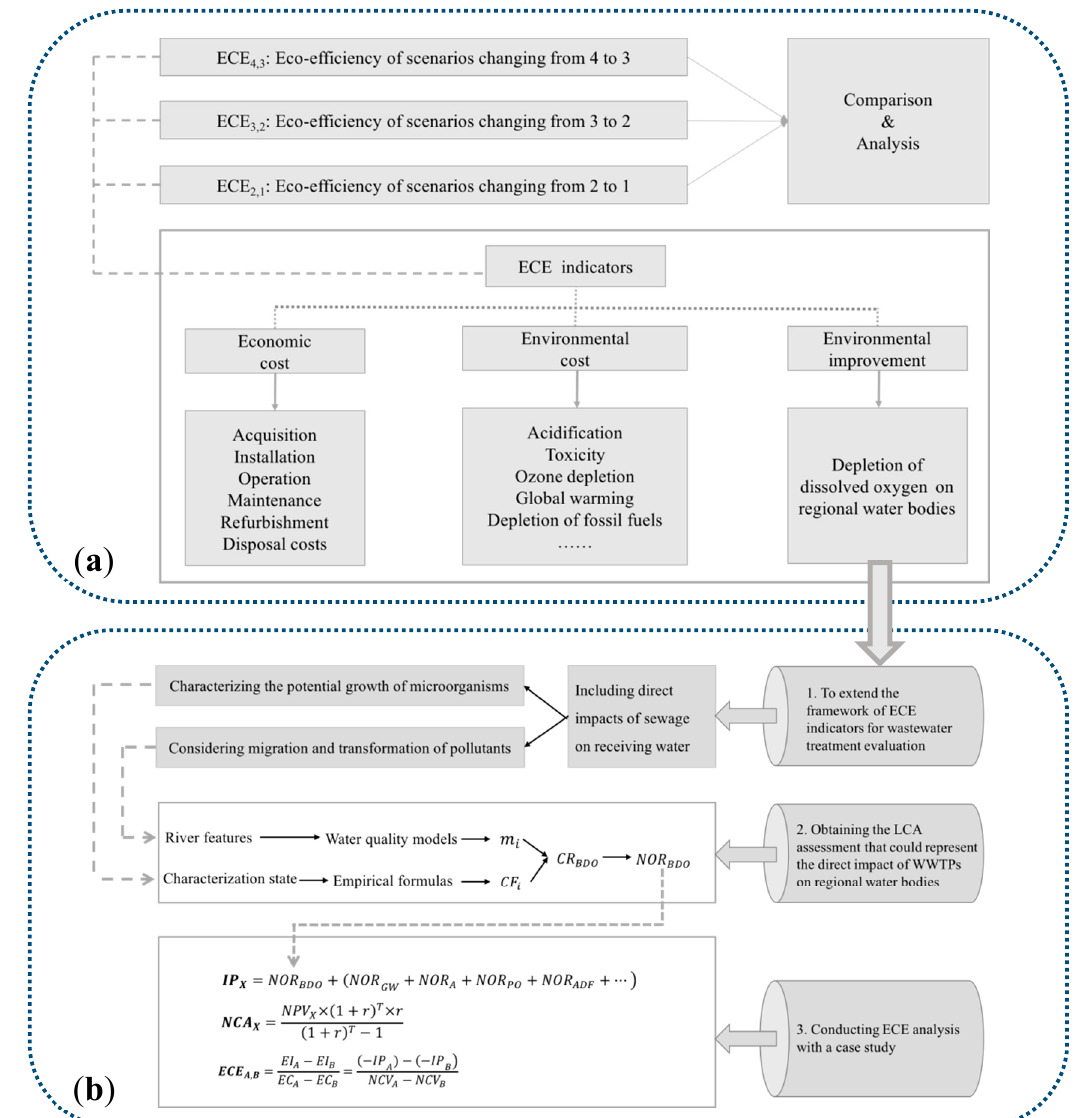
Figure 1. Framework of this study: ( a ) shows the general scheme for the conduction and comparison of environmental cost efficiency (ECE) indicators between different scenarios; ( b ) shows the development of the extended ECE indicators in this study.